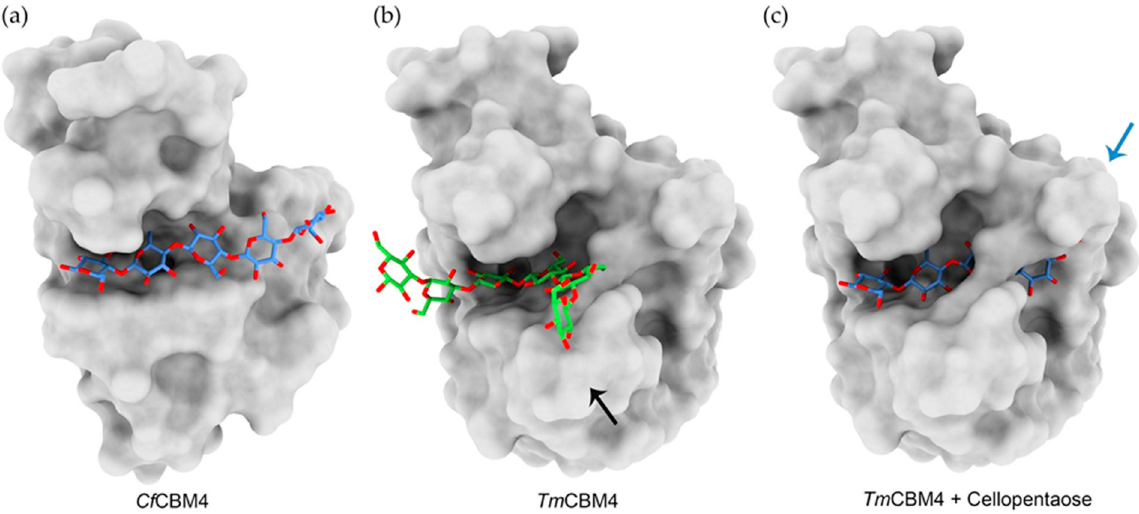
Figure 4. Substrate specificities of different CBM4 are dictated by active site conformation. Gray- colored Van der Waals surfaces of ( a ) Cf CBM4 bound to cellopentaose (blue) and of ( b ) Tm CBM4 bound to laminarihexaose (green). Both ligands are shown in stick representation. Tm CBM4 shows a more “U-shaped” binding site as a result of two loop extensions (black and blue arrows). An extra loop (black arrow) on Tm CBM4 creates an extra binding surface that interacts with the non-reducing end of the laminarin oligosaccharide. Panel ( c ) was obtained by superposing the structures of Cf CBM4 and Tm CBM4, and shows how the second extra loop on Tm CBM4 (blue arrow) does not allow the more linear cellulose oligosaccharide to fit into the binding site. PDB codes: 1gu3 ( Cf CBM4), 1gui ( Tm CBM4).